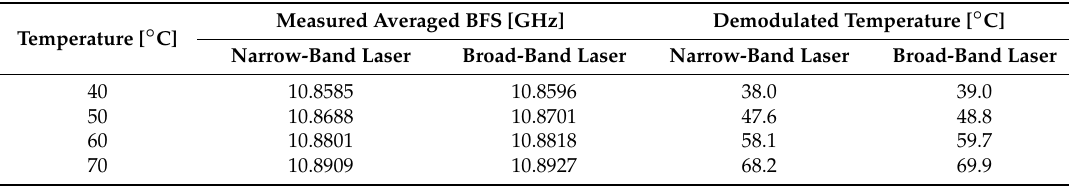
Table 3. Measured averaged BFS and demodulated temperature of the heated fiber at different thermostatic water bath